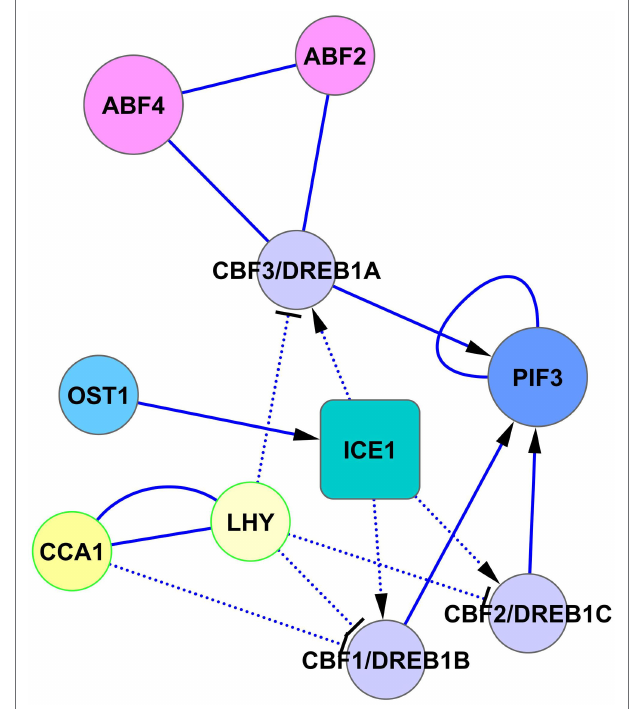
The activated CBF-cold-responsive ( COR ) cold-signaling pathway increases cold tolerance. Transcription of CBF1/DREB1B , CBF2/DREB1C , and CBF3/ DREB1A is regulated oppositely by ABA signaling via the cold-activated SnRK2.6-ICE1 pathway and light signaling via CCA1/LHY. CCA1 and LHY suppress the expression of DREB1s under unstressed conditions and are rapidly degraded in response to cold (Kidokoro et al., 2021), allowing activation of the CBF- COR cold signaling pathway. In turn, CBF proteins, accumulated in response to cold, interact with PIF3 and prevent PIF3 degradation with subsequent de-repression of COR genes. Abbreviations: ABFs, abscisic acid responsive elements-binding factors; PIF3, transcription factor PIF3; OST1/SnRK2.6, SNF1-related protein kinase 2.6; ICE1, inducer of CBP expression 1; CCA1, circadian clock associated 1; LHY, protein late elongated hypocotyl; CBFs/DREBs, dehydration-responsive element-binding